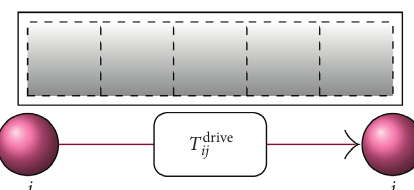
Figure 3: One module representing a simplified driving section with five cells. At arrival to the module at node (i), the activity of driving is